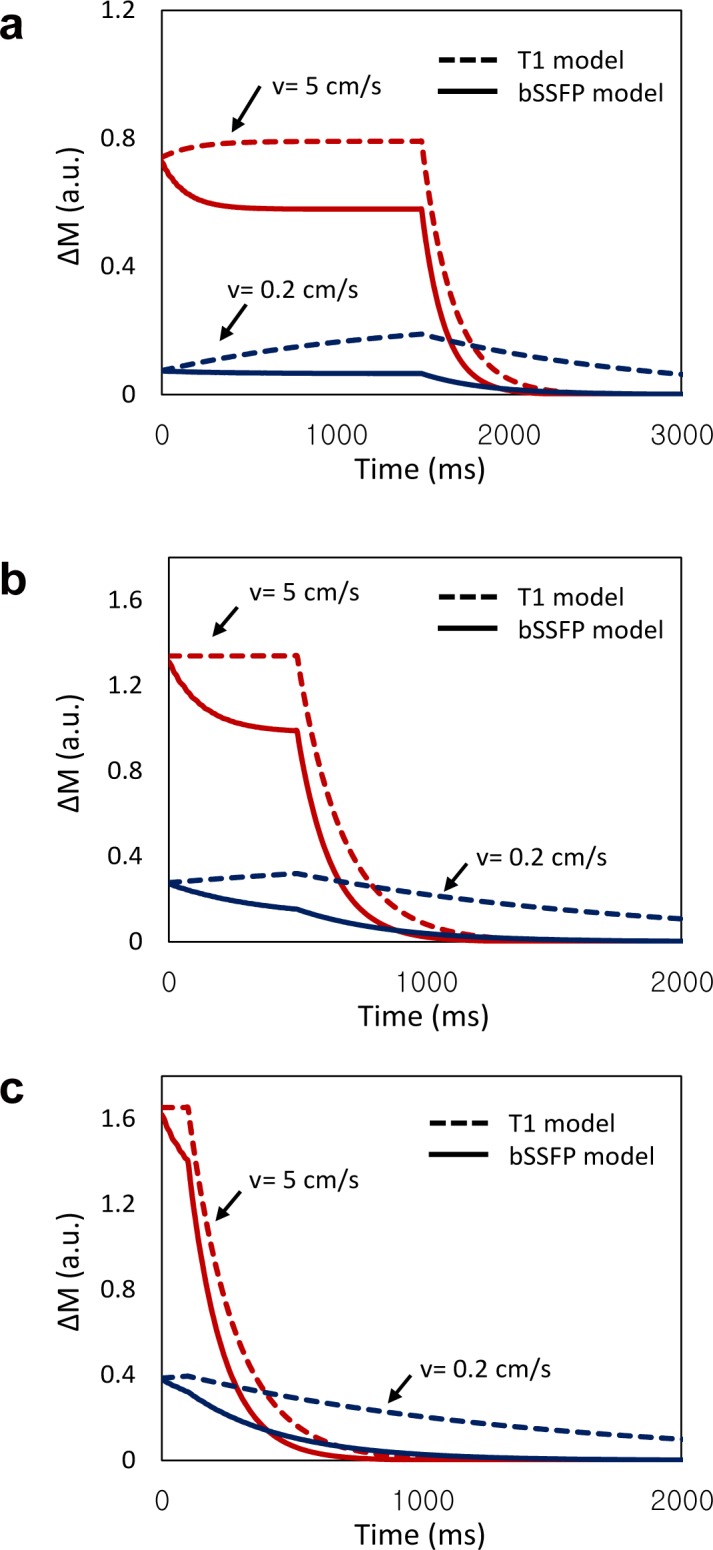
Simulation results of magnetization difference between control and labeling scans with two flow rates (0.2 and 5 cm/s) for ALADDIN with multiphase bSSFP sequence.The simulations were performed at ATT of 1500 ms (a), 500 ms (b), and 100 ms (c). The red and blue lines represent the flow rates of 0.2 cm/s and 5 cm/s, respectively. The solid and broken lines represent the results for fitting to bSSFP model and T1 model, respectively. ΔM represents magnetization difference between control and labeling scans. a.u. represents arbitrary unit.